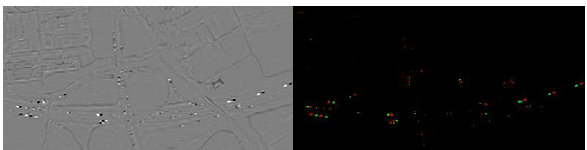
Figure 16: Sample processing of bands, step 2, example WorldView-2, left: difference image relative to median, right: de- tected positive and negative objects